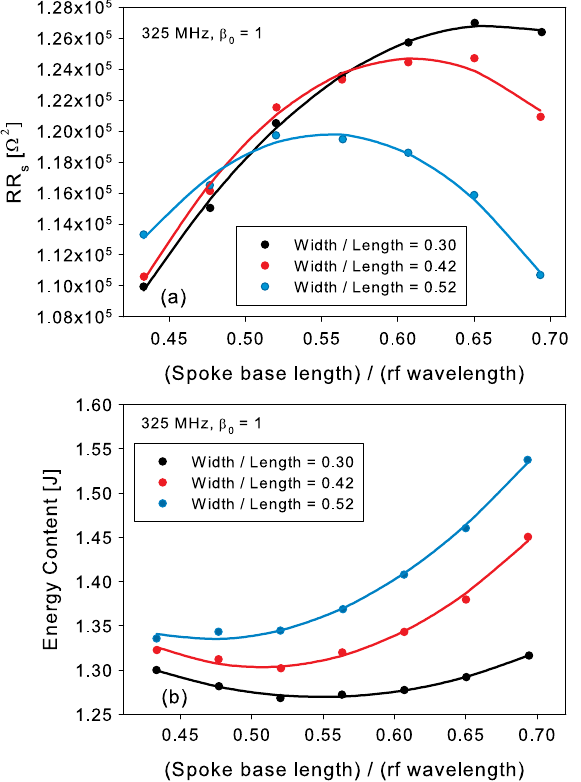
FIG. 13. Dependence of (a) RR s and (b) energy content (at 1 MV = m ) on spoke base size. Three different transverse spoke base shapes are presented, identified by the ratio of base width to length. For each data point, both the base width and length are changing, but the ratio remains